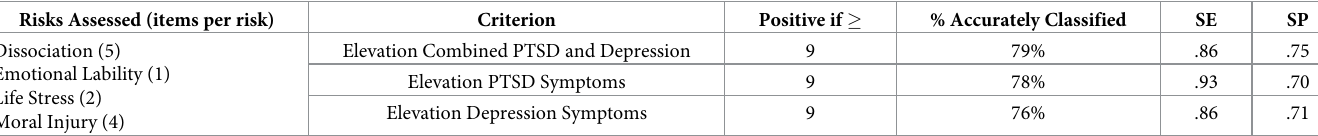
Table 5. Classification performance of screen including four risk factors to predict elevations in a combined index of PTSD and depression, PTSD, and depression. Risks Assessed (items per